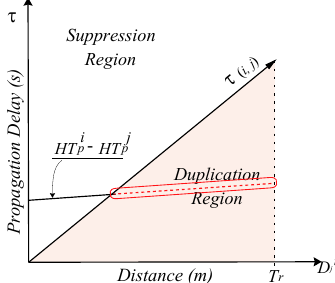
Figure 2. Relationship between holding time difference and broadcast suppression in the underwater